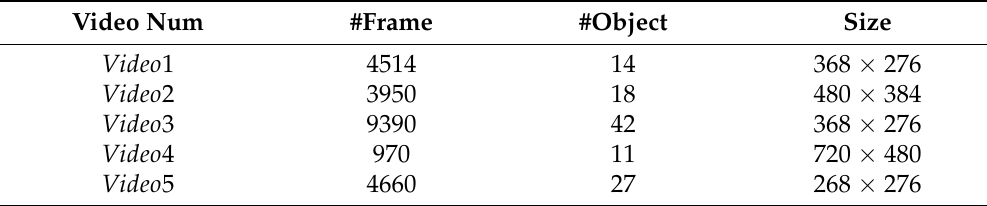
Table 1. Information on the